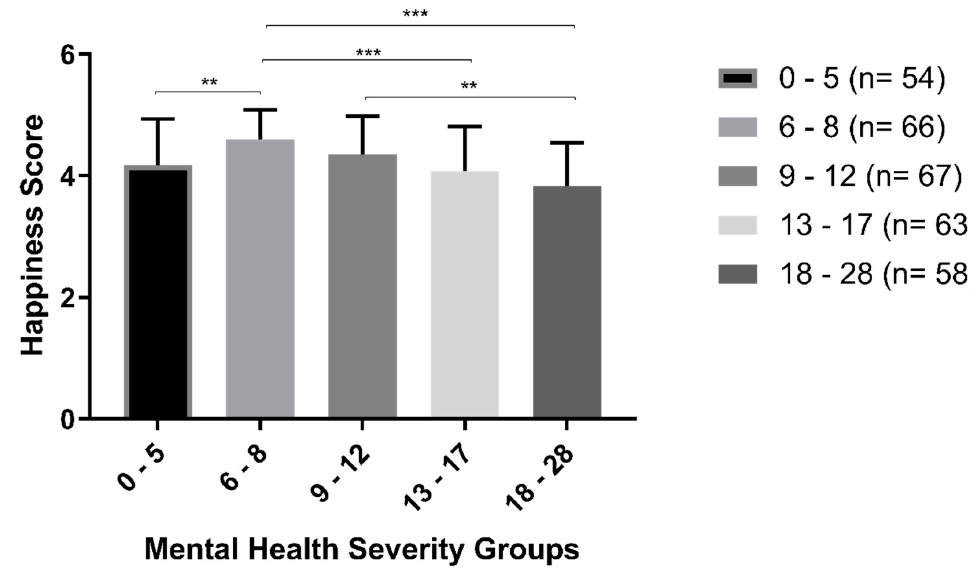
Figure 2. Mental health severity groups comparison on happiness level. The bars represent Mean ± SD . * p < 0.05, ** p < 0.005, *** p < 0.001.